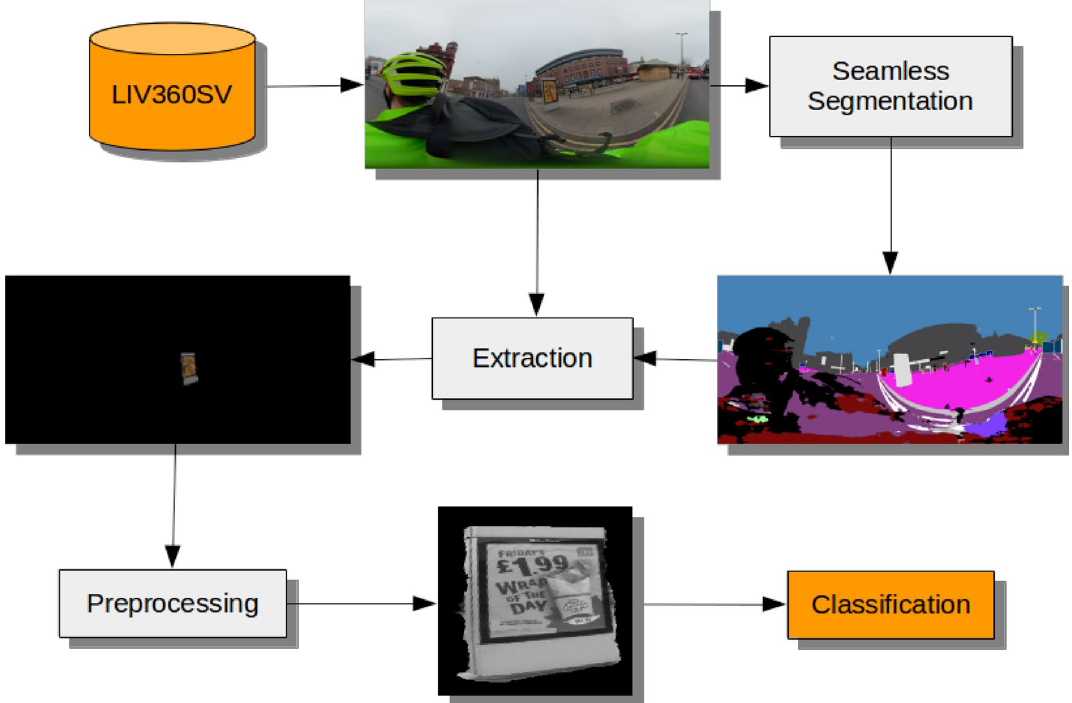
Figure 2. An illustration of our advertisement classification workflow. (The final image was converted to monochrome for the Figure—colour images are used in